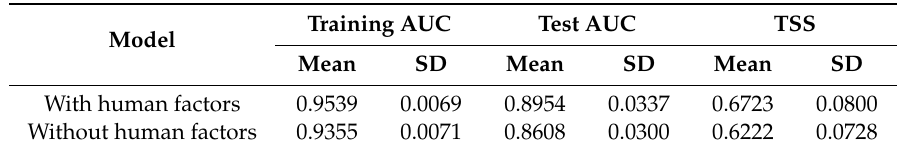
Table 3. Wilcoxon paired test values showed significant difference of plateau pika’s distribution in the Qinghai Lake basin with and without human factors.